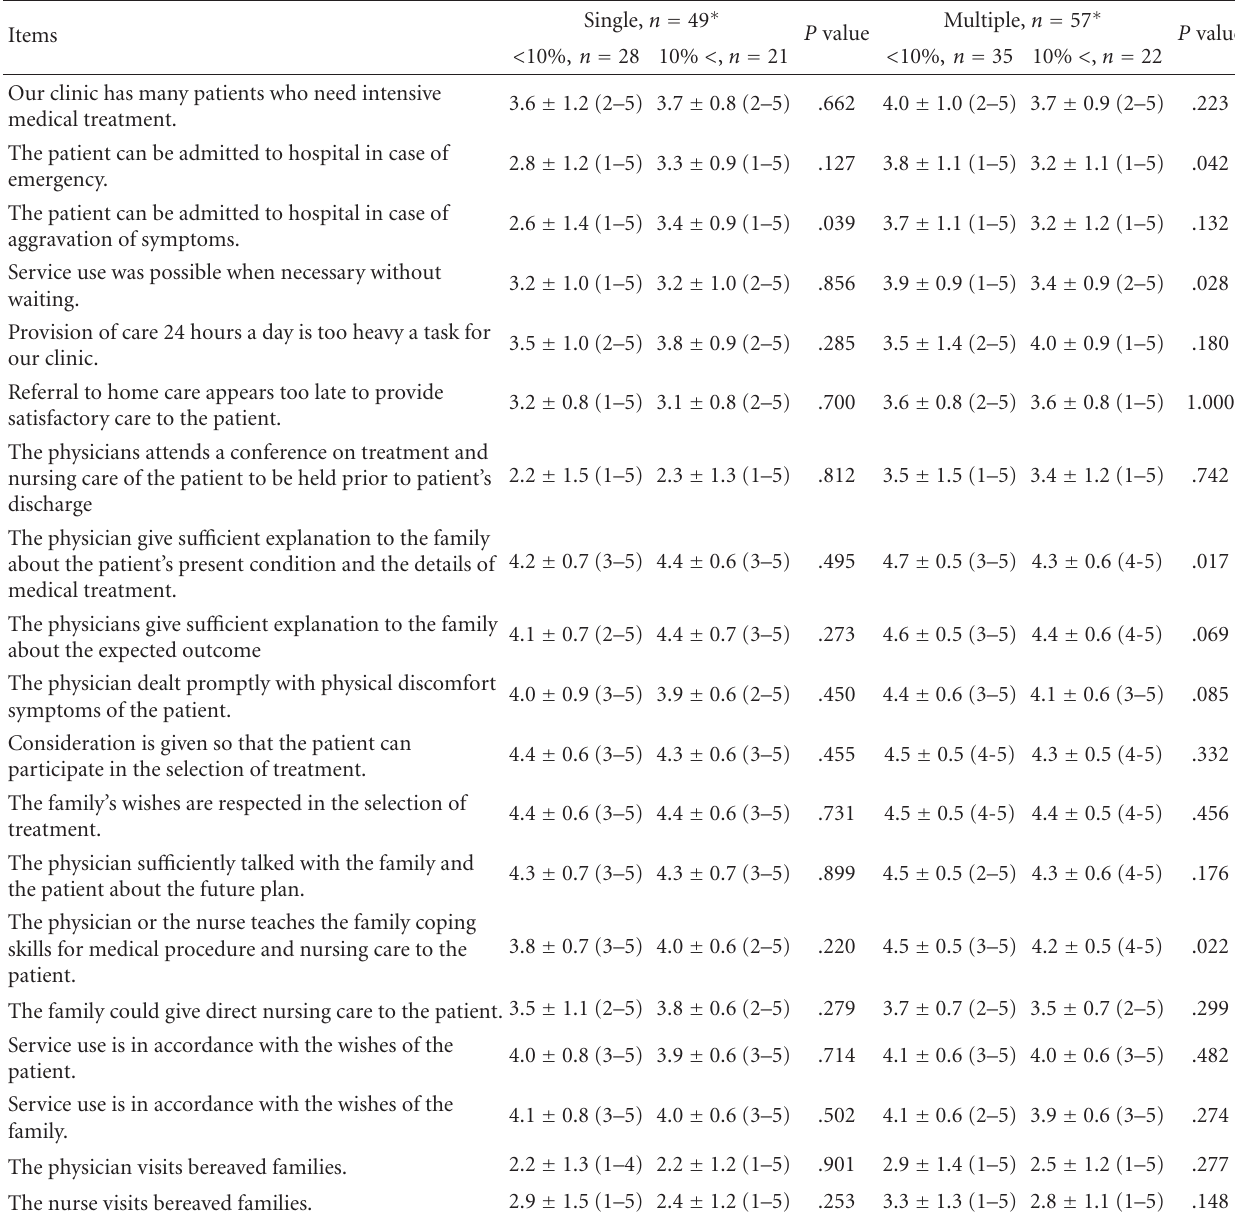
Table 4: Relationship between the proportion of home deaths and home care self-assessment.